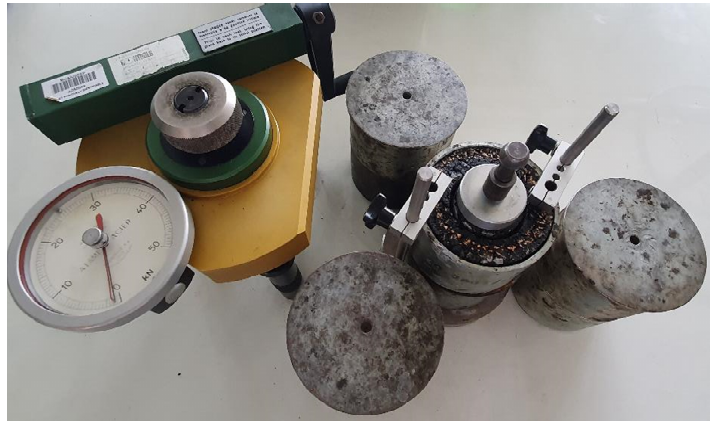
Figure 3. Pull-o ff tensile strength testing Figure 3. Pull-off tensile strength testing setup.